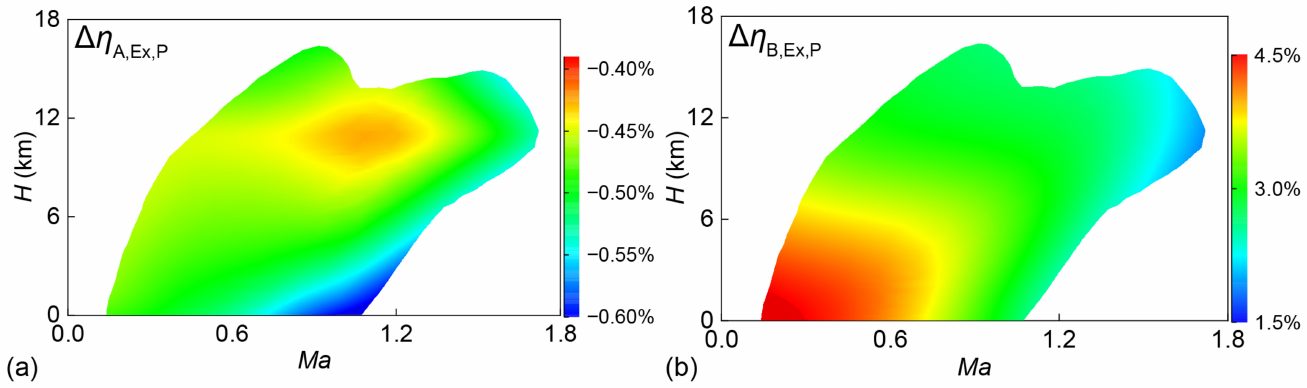
Figure 17. Variations of propelling exergy efficiency in the full flight envelope. ( a ) The ratio of η A,Ex,P in schemes A and F-119; ( b ) The ratio of η B,Ex,P in schemes B and